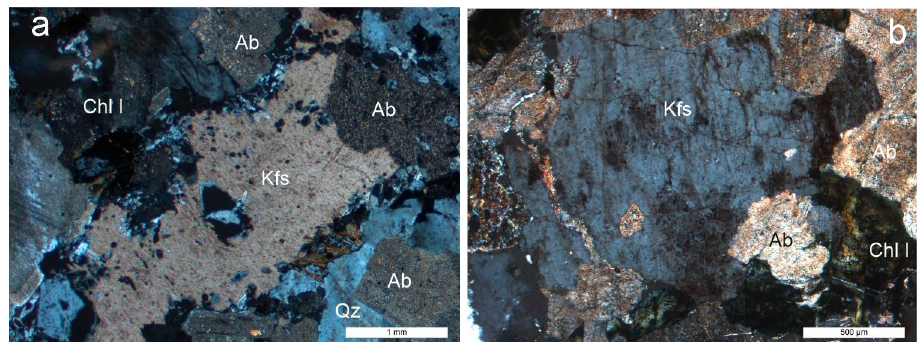
Figure 6. Microphotographs of hydrothermally altered granitoids (Ab—albite, Chl—chlorite, Kfs— K-feldspar, and Qz—quartz) with hydrothermally originated K-feldspars during K-feldspathization, Nahošín uranium deposit, ( a )—ample R-707; ( b )—sample R-705. Crossed polarizers.